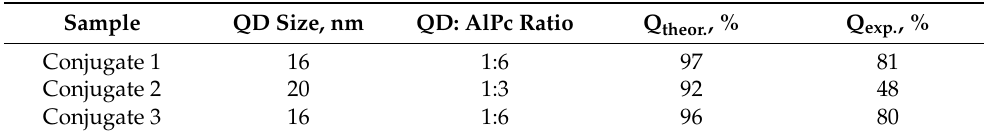
Table 4. Values of theoretical and experimental FRET depending on the ratio of donor and acceptors in the